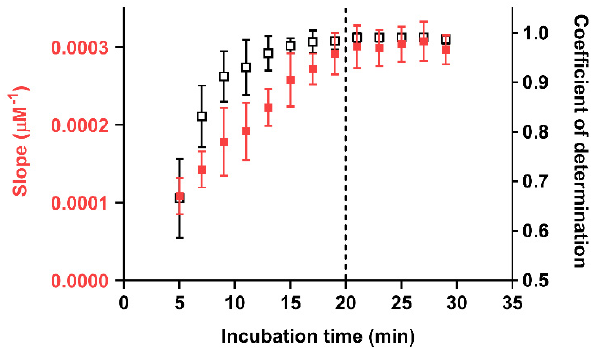
Figure 3. Slope (red) and linear regression coefficient of determination (black) values for calibration curves obtained at different incubation times in analytical cartridges prepared with 0.30 mg/mL of Au(III) chloride. The dashed line indicates the incubation time (20 min) selected for the assay. Each point is the mean ± SD of three experiments.